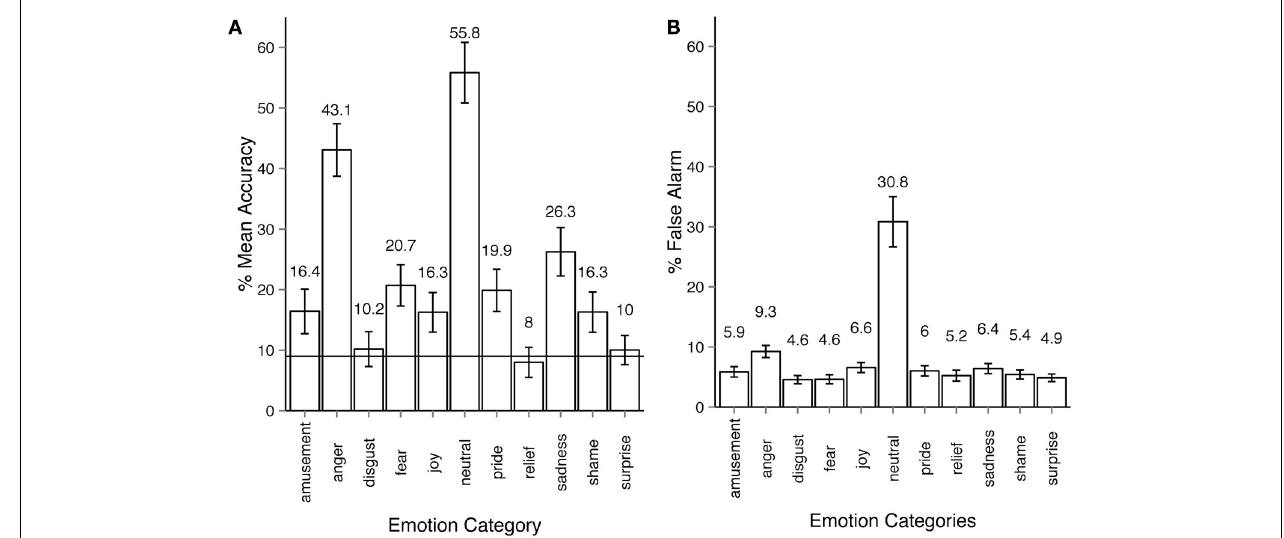
FIGURE 3 | Emotion recognition in experiment 2. (A) Accuracy across emotion categories. The horizontal line shows the chance level threshold of 9%. (B) False alarm rate across emotion categories. All error bars show 95% confidence intervals. The participant observed a stick-figure representation of human upper-body motion. The task was to recognize the emotion category expressed by the actor and respond by first